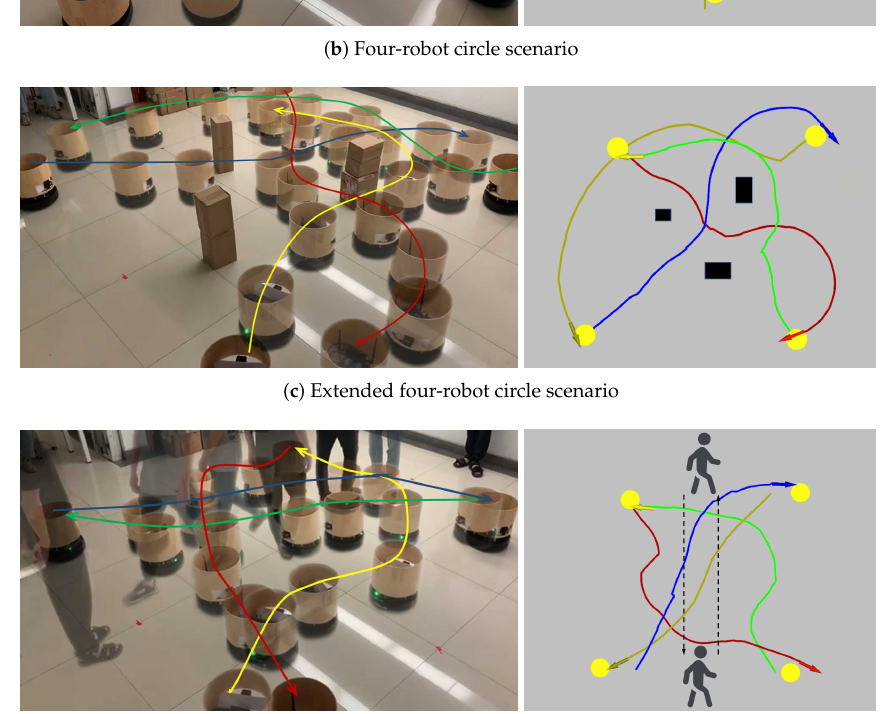
Figure 18. ( a ) Four-robot cross scenario, where two groups of robots cross each other. ( b ) Four-robot circle scenario, where four robots are placed on a circle and their targets are set at opposite positions. ( c ) Extended four-robot circle scenario, which is extended from the four-robot circle scenario by randomly placing some static obstacles. ( d ) Four-robot circle scenario with pedestrians, where two pedestrians are asked to walk across the paths of all robots. Subfigures on the left show the trajectories of the robots in the real world. Subfigures on the right show the trajectories recorded by robots based on their own localizations. Notice that the trajectories recorded by robots are not that smooth which is mainly due to the low accuracy of the robots’ localizations. Lines with different colors denote trajectories of different